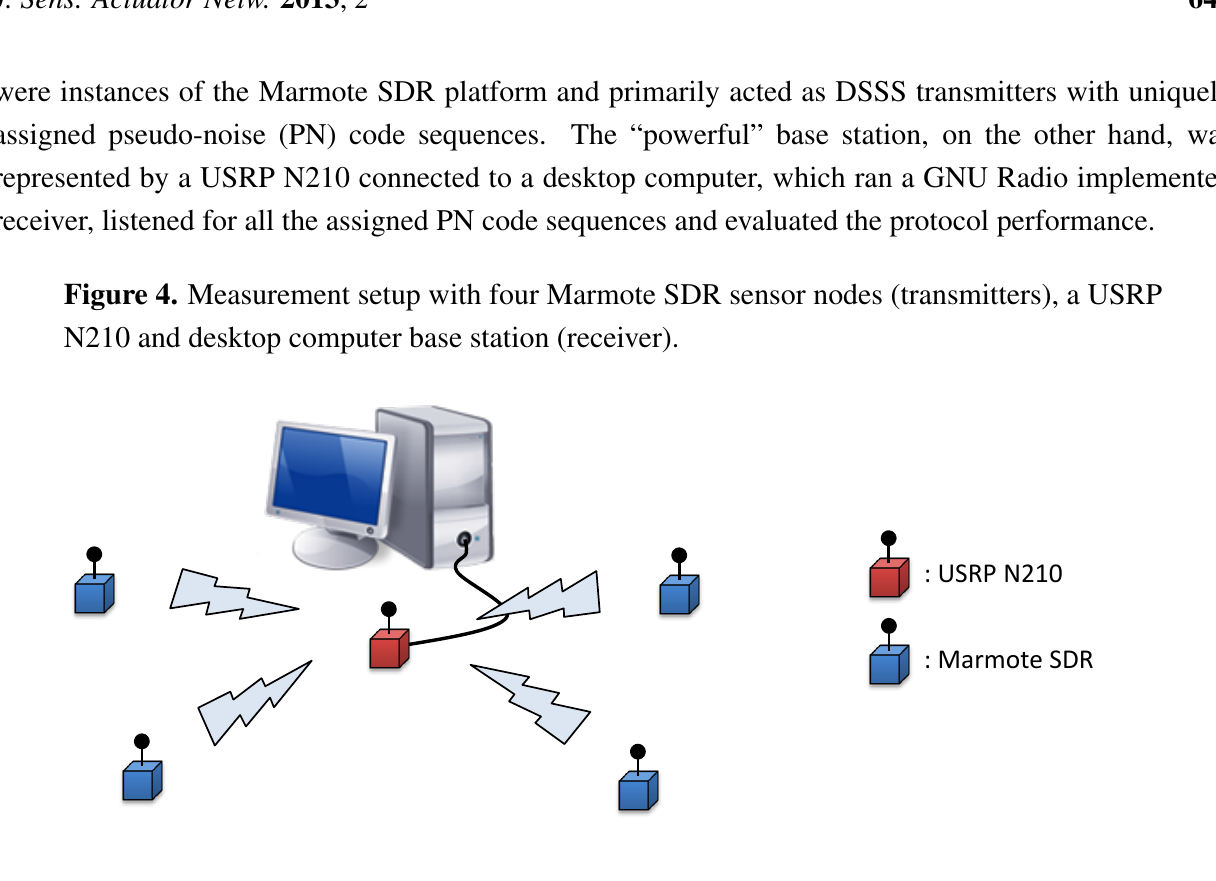
: USRP N210 : Marmote